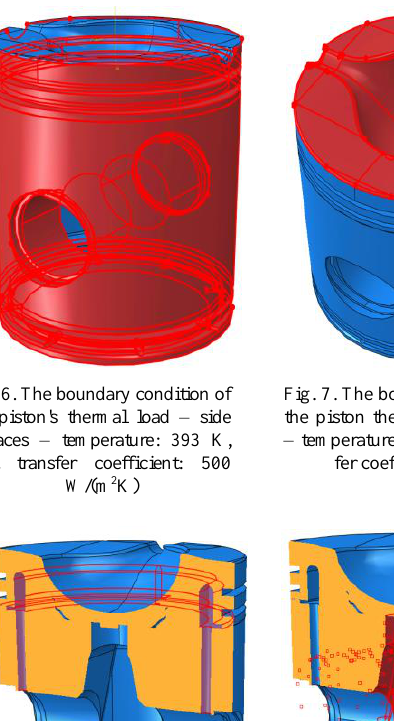
Table 4. Material properties of aluminium alloy called M174 + [1] Temperature [K]